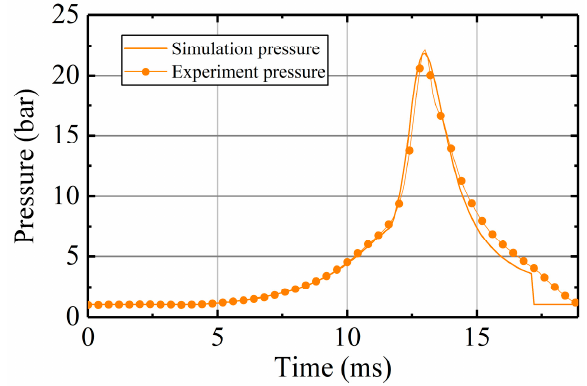
Figure 14. The in-cylinder pressure verification (stable operation).